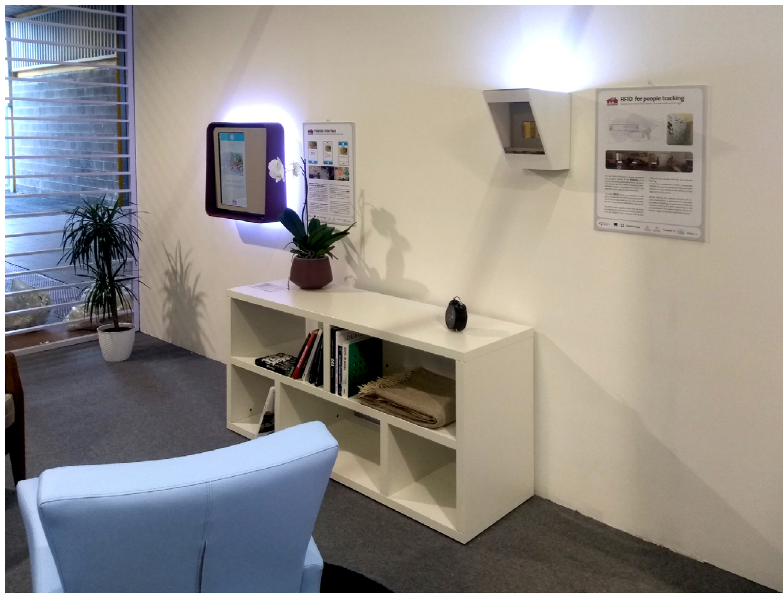
FIG. 5 The image shows the functioning prototypes of the HABITAT system: the digital ‘frame’ interface (top-left); smart chair; and indoor localization system inside the lamp (top-right). Source: M. Marchi,